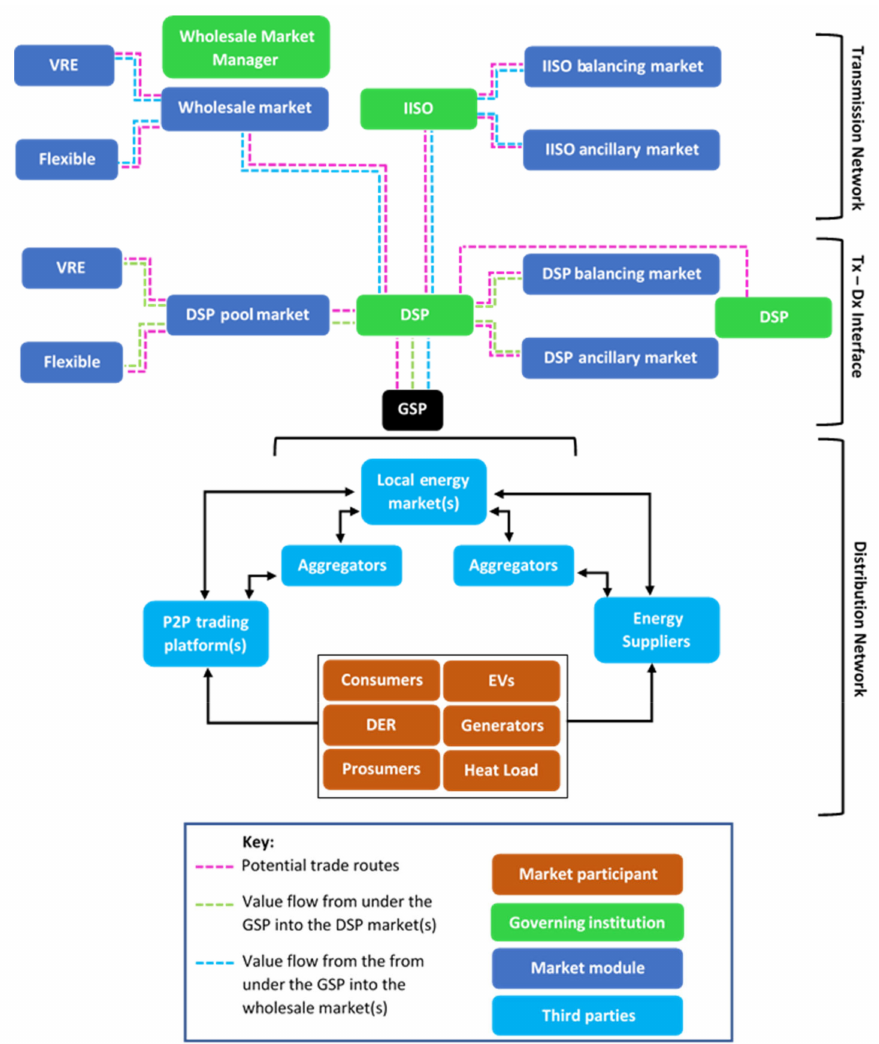
Figure 1. Schematic of the proposed electricity market design with potential trade routes, value from the GSP into the DSP and wholesale market identified. Only one GSP for illustrative clarity. In reality, there would be multiple GSPs within a DSP’s geographical remit. Entities listed within a GSP are not an exhaustive list, but a representation of several likely parties to be operational within this geographical area. Tx and Dx refer to transmission network and distribution network, respectively. Market participants refer to generating or demand-side asset(s), such as prosumers, EVs and those with flexible electrified heat load. Authors’